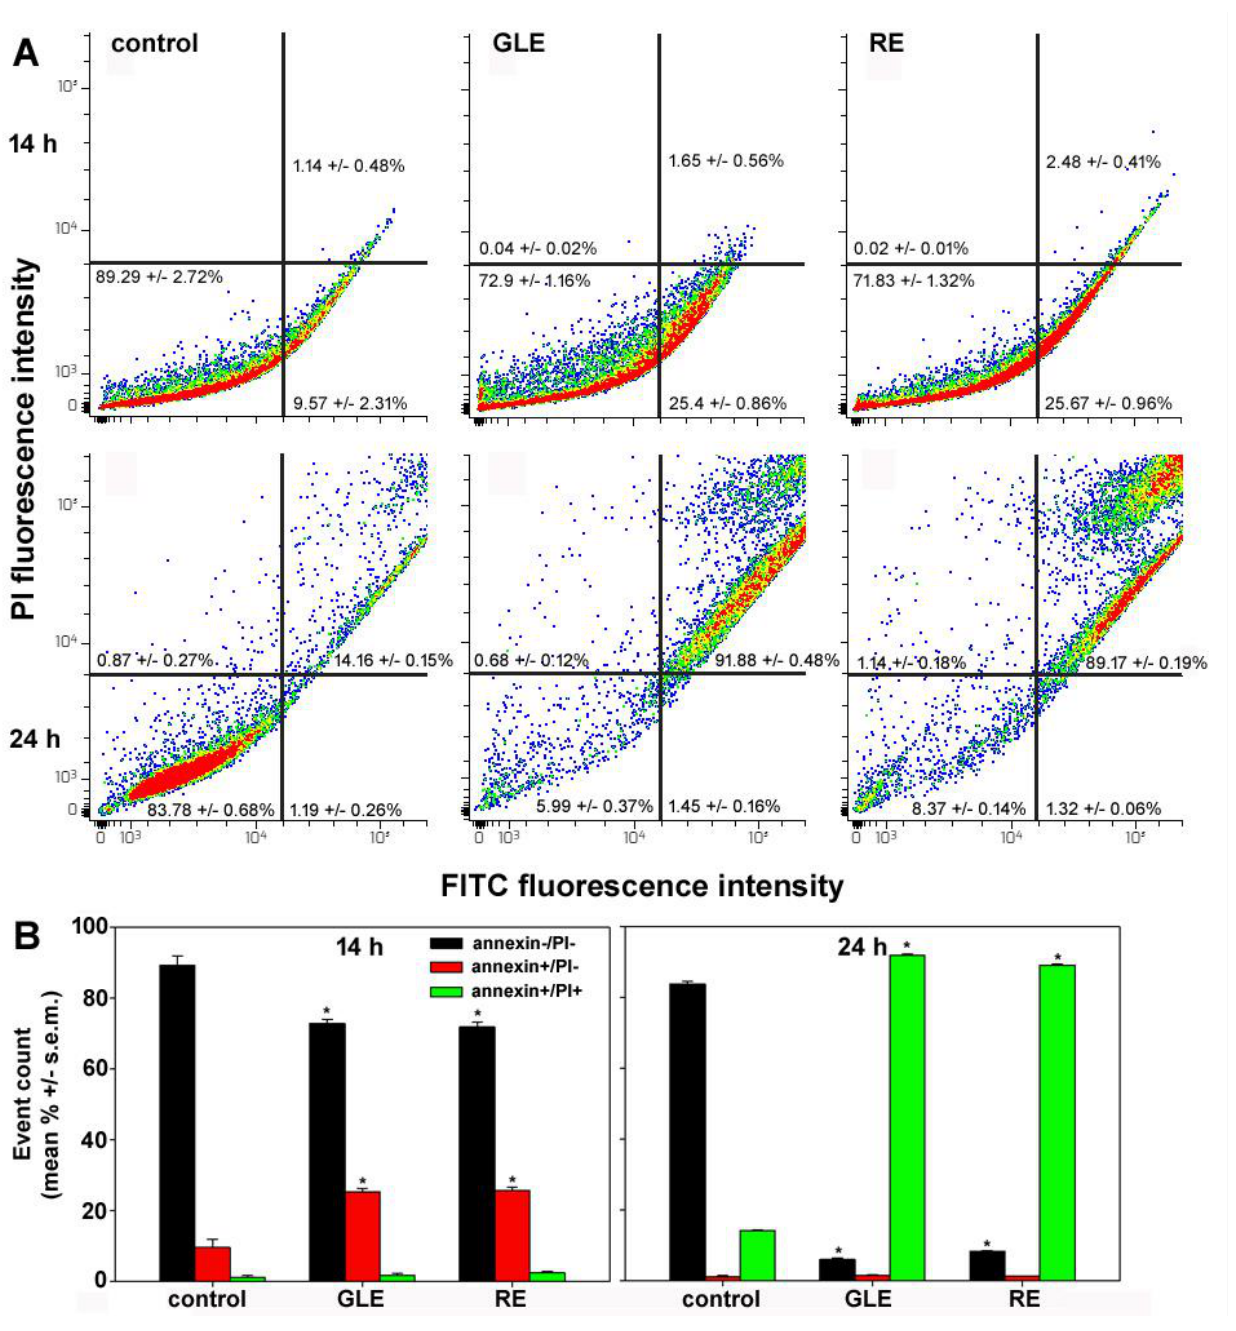
Figure 3. ( A ) Flow cytometric assays for apoptosis in HepG2 cells cultured in control conditions or exposed to the IC 50 of GLE or RE for 14 or 24 h. The plots show the results of